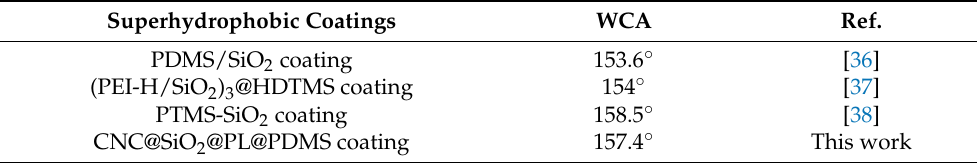
Table 2. Comparison of different superhydrophobic coatings for